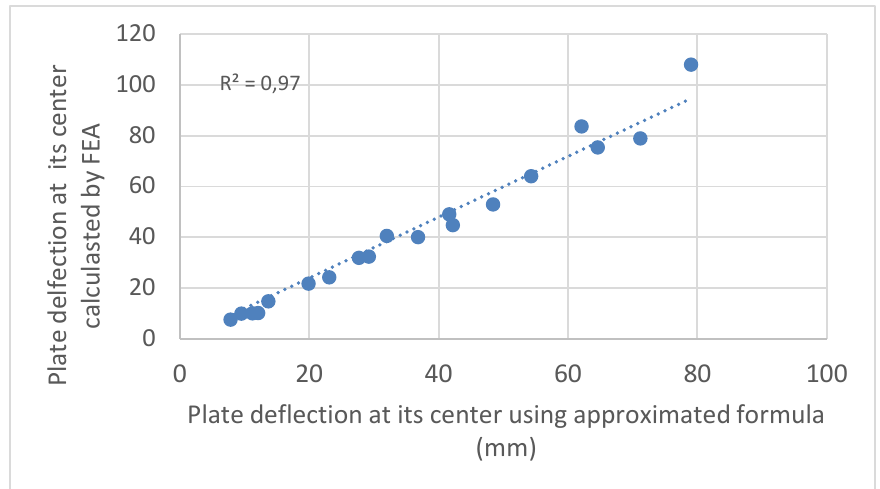
Fig. 6: Comparison between the maximum values of plate deflection at its center calculated using the approximated solution proposed by Chia and results obtained by FEA